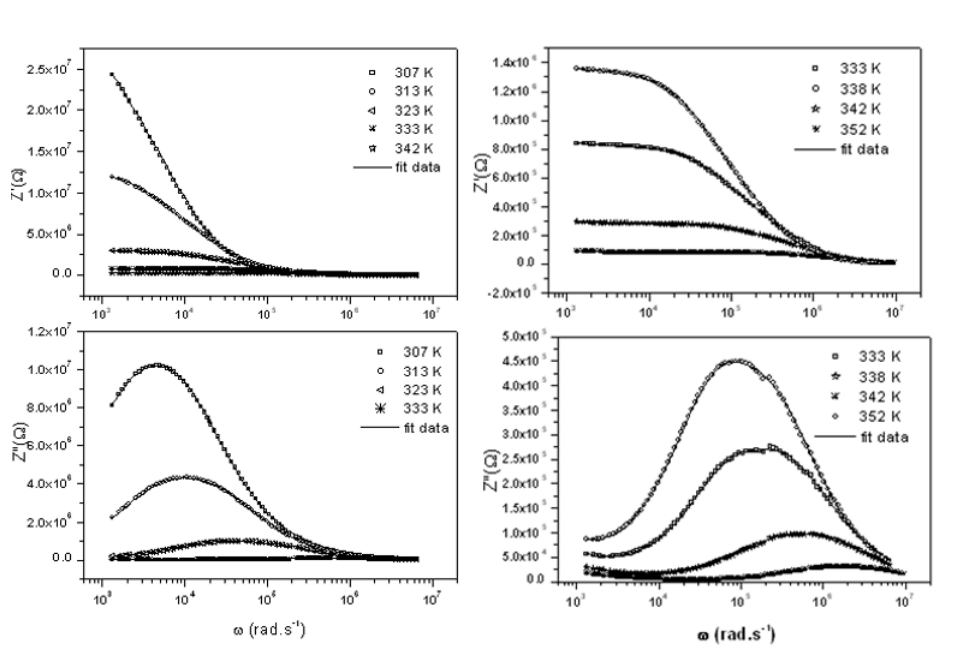
Fig.7. Frequency dependence of the Z’ and Z” of C